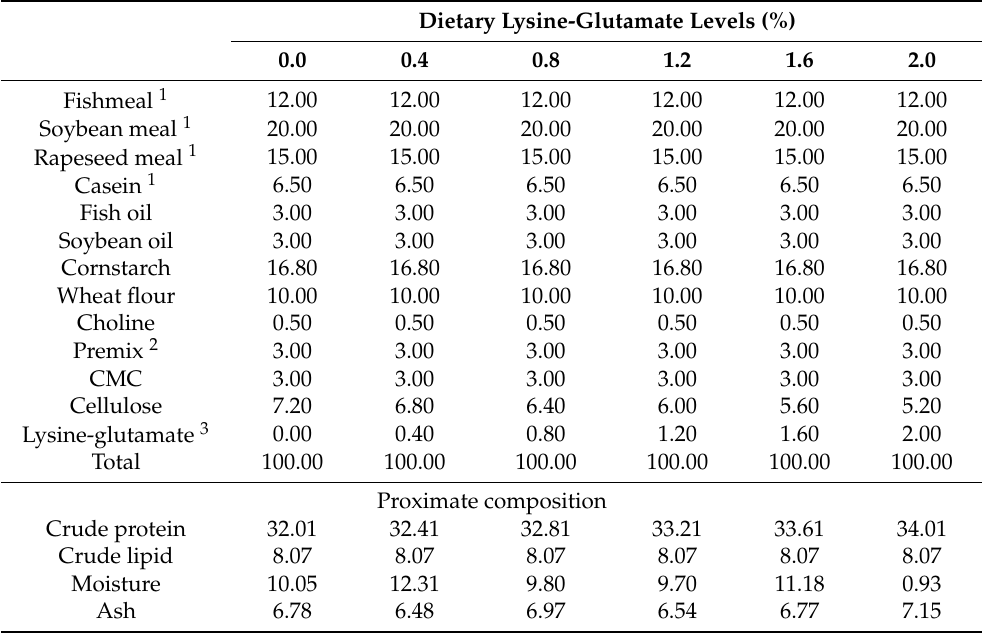
Table 4. Diet formulation and chemical composition of the lysine-glutamate dipeptide diets (% dry matter).